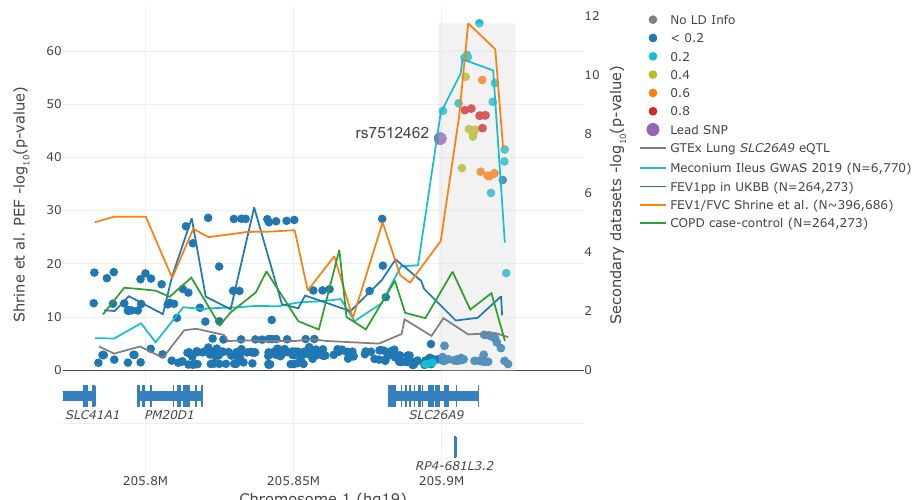
Fig. 5 Lung function measures colocalize with CF meconium ileus GWAS at the SLC26A9 locus. Visualization of colocalization using LocusFocus 46 . Peak expiratory fl ow (PEF) GWAS summary statistics ( n = 345,265) from Shrine et al. 33 are shown as circles with corresponding left y-axis against lines that trace (1) GTEx v7 adult lung eQTLs for SLC26A9 ; (2) meconium ileus GWAS 1 summary statistics; (3) FEV 1pp GWAS summary statistics from UKBB participants ( N = 263,461; 22,071 of which have COPD as per GOLD level 2-4 de fi nitions); (4) FEV 1 /FVC ratio GWAS summary statistics from Shrine et al. 33 (highest effective sample size is 396,686, a function of sample size ( N = 400,102) times imputation quality); and (5) Chronic obstructive pulmonary disease (COPD) case-control association summary statistics (22,071 cases and 241,390 controls). The choice of y-axis scales and the primary dataset is for visualization purposes only and does not in fl uence colocalization test result conclusions. There is a known gap on the human reference GRCh37 at chr1:205,922,708-206,072,707, which corresponds to the white gap in the fi gure as no variants exist. Lines traverse the lowest p -values per window as a visual guide (window size = 6.67 Kbp) with corresponding right y-axis. A total of 85 SNPs in this region were used to test for colocalization using the Simple Sum method 1,45 . The Simple Sum colocalization test 1,45 is implemented in the grey region, which was selected to match the observed peak at chr1:205,899,000- 205,925,000. The color of the circles re fl ects the pairwise linkage disequilibrium (LD) with the rs7512462 lead SNP (purple) using the European subset of the 1000 Genomes Project, with varying strength of LD depicted with a different colour as denoted in the